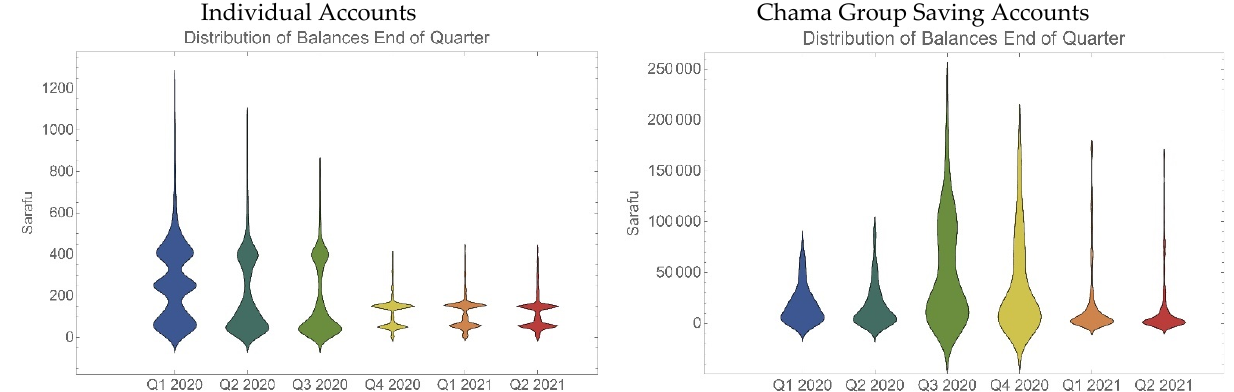
Figure 5. Violin Distribution Charts for End of Quarter Balances. Different colors represent different quarters from Q1 2020 to Q2 2021. Data from the xDai Blockchain. Units in Sarafu where approximately 100 Sarafu equals US$1.